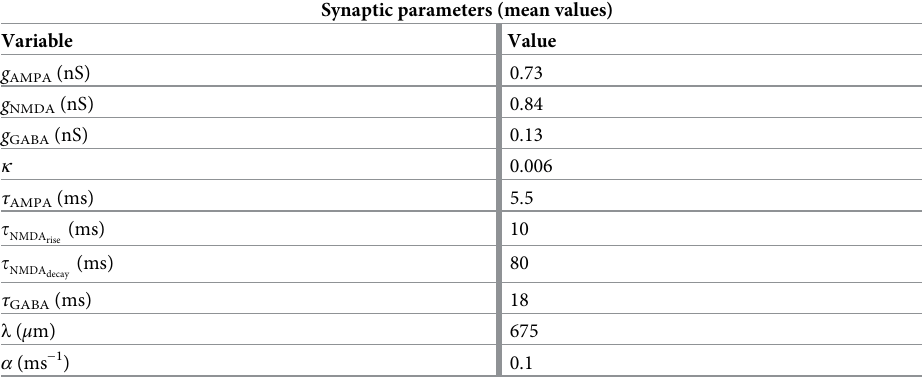
Table 4. Mean values of the synaptic parameters in the anatomically detailed